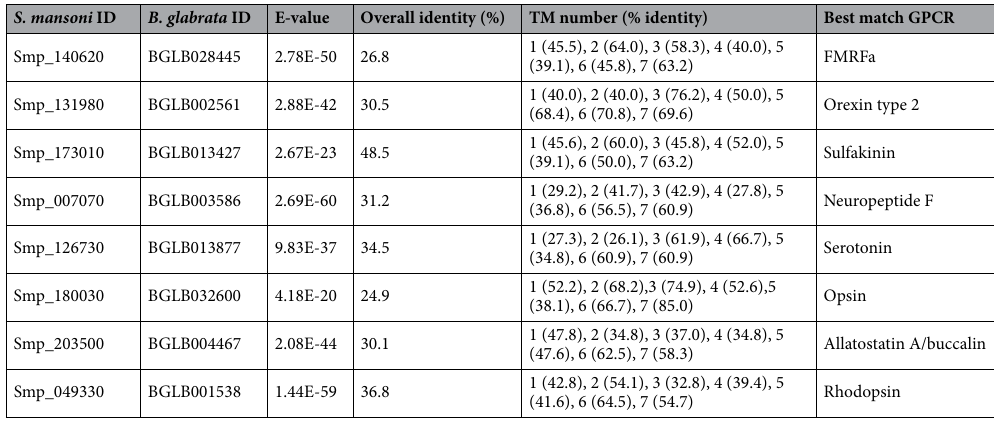
Table 1. Comparative sequence identity between Biomphalaria glabrata and Schistosoma mansoni GPCR